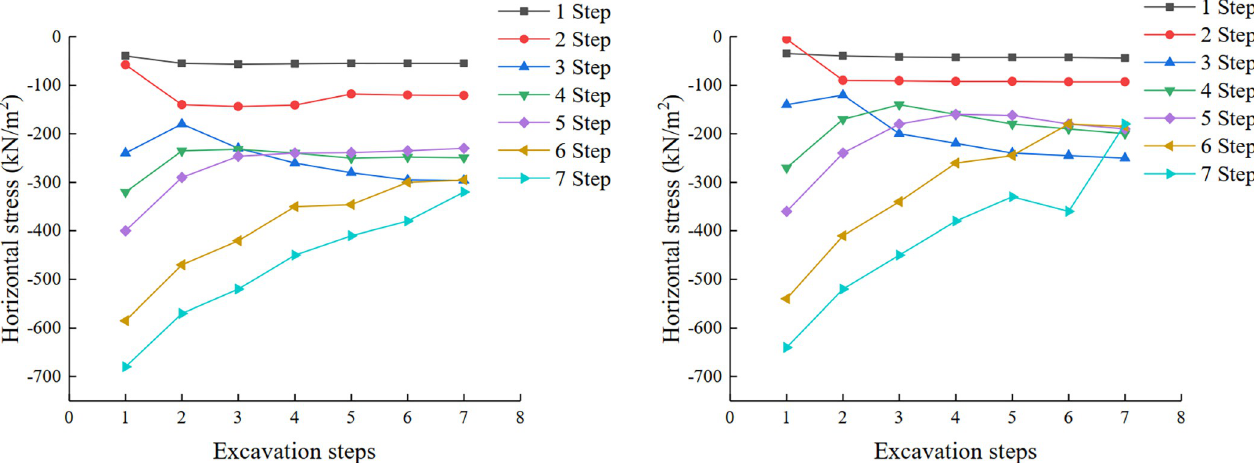
Fig 9. (a). The curve of horizontal stress variation of each step during slope excavation (in the middle of slope). (b). The curve of horizontal stress variation of each step during slope excavation (at the top of the slope).